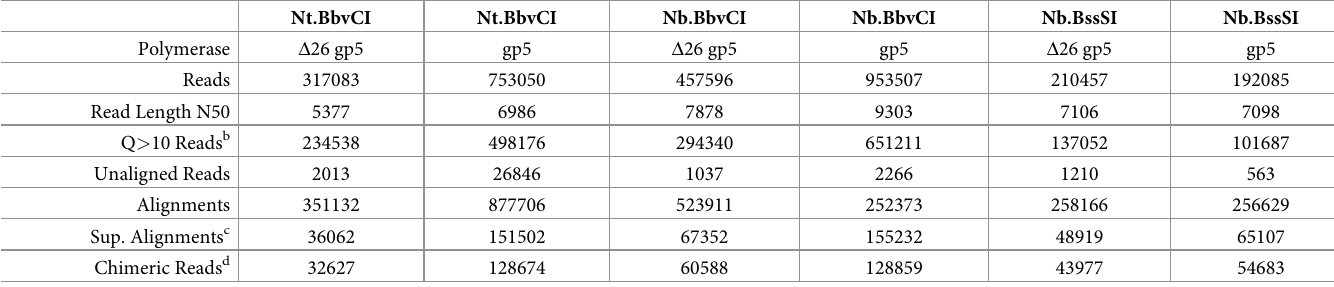
Table 1. Nanopore sequencing statistics for T7 SDA